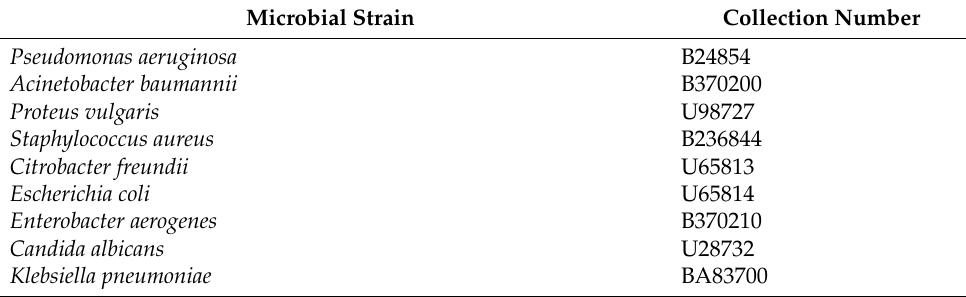
Table 9. Microbial strains and their collection